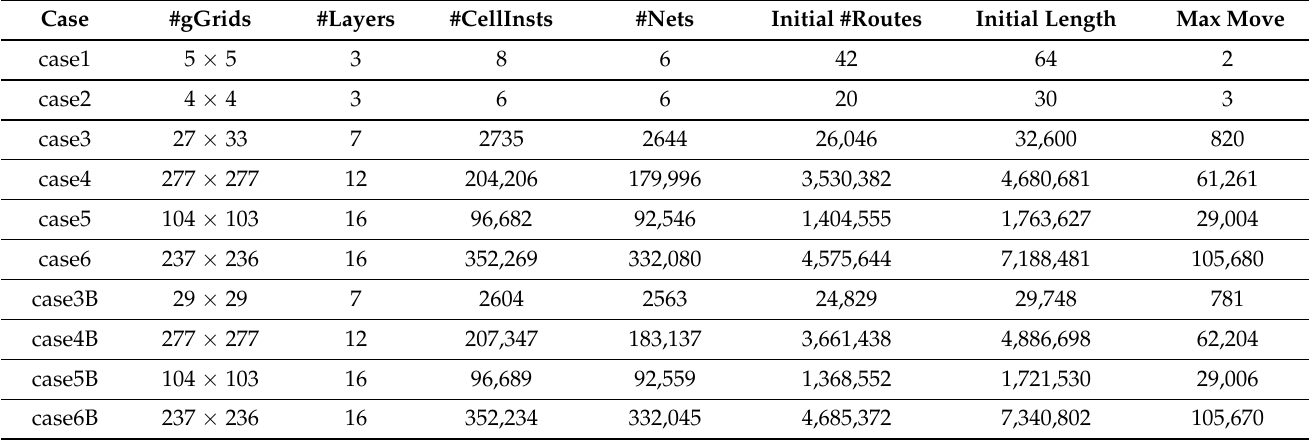
Table 1. Benchmark statistics.